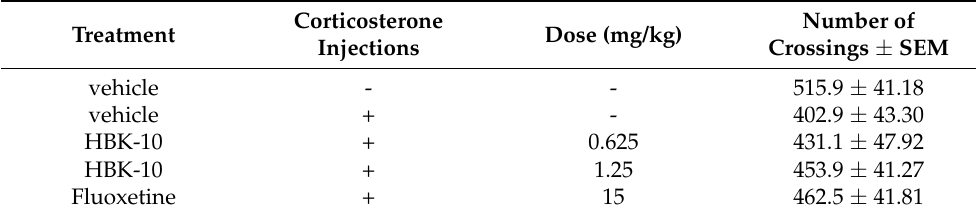
Figure 6. The effect of p -chlorophenylalanine ( p CPA; Panel ( A )), and WAY-100635 (Panel ( B )) on antidepressant-like activity of HBK-10 in the forced swim test in mice. p CPA (200 mg/kg) was injected intraperitoneally ( ip ) once daily for three consecutive days. 24 h after the last injection and 30 min before the test mice received ip either studied compound or vehicle (1% Tween). WAY-100635 (0.1 mg/kg) was administered subcutaneously ( sc ) 15 min before tested compound, then 30 min before the test mice received ip either studied compound or vehicle (1% Tween). The results are presented as box plots showing the following data: mean (‘+’), median (horizontal line), upper and lower quartile (the width of the box shows interquartile range), upper and lower extreme (whiskers). Statistical analysis: Shapiro–Wilk test for normality, Brown–Forsythe test for homogeneity of variance, and two-way ANOVA (Newman–Keuls post hoc); * p < 0.05, ** p < 0.01, *** p < 0.001; n = 8–10 mice per group. Table 6. The effect of HBK-10 and fluoxetine on locomotor activity in corticosterone-treated mice after a chronic